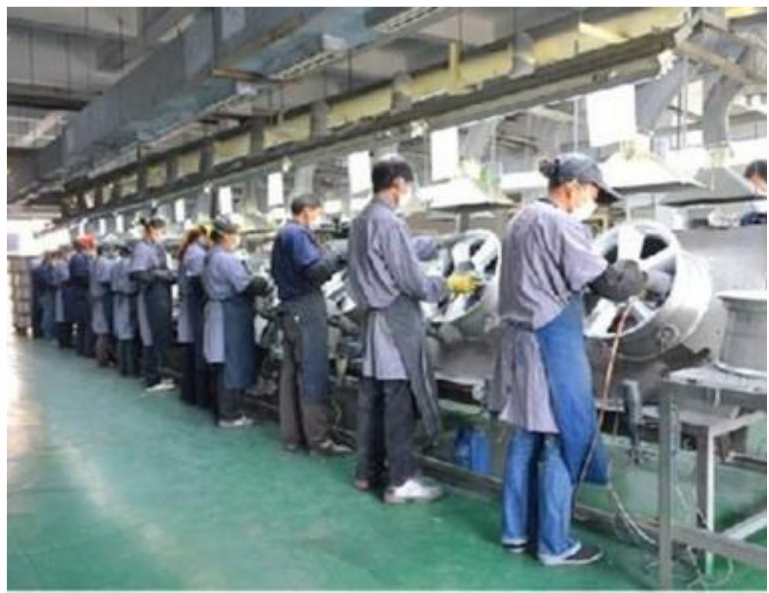
Figure 5. Workers on duty at the workstations. From Li et al. (2016). Copyright (2016), with permission from